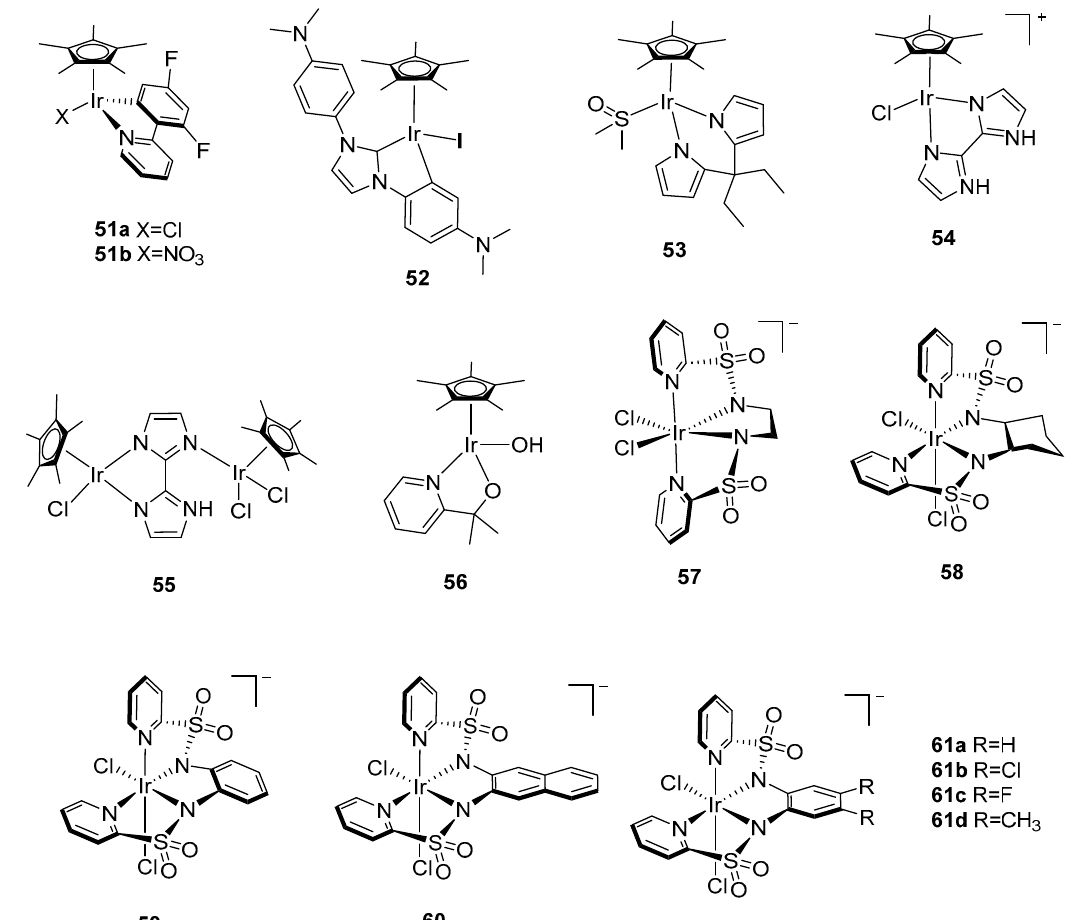
Figure 5. Chemical structures of iridium catalysts 39–61 for water oxidation: [Ir III (ppy) 2 (bipy)] + ( 39 , ppy = 2-phenylpyridine, bipy = 2,2 ′ -bipyridine) [109]; [Ir(ppy) 2 (H 2 O) 2 ] + ( 40a , ppy = 2-phenylpyridine); [Ir(5-R 1 ,4 ′ -R 2 ,2- phenylpyridine) 2 (H 2 O) 2 ]